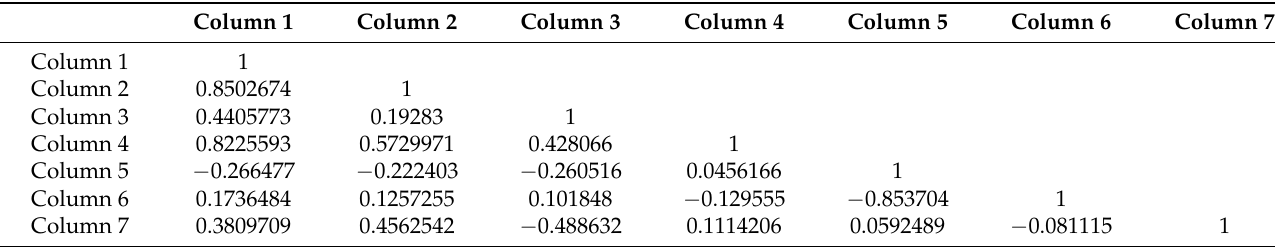
Table 17. Correlation matrix for model (10).